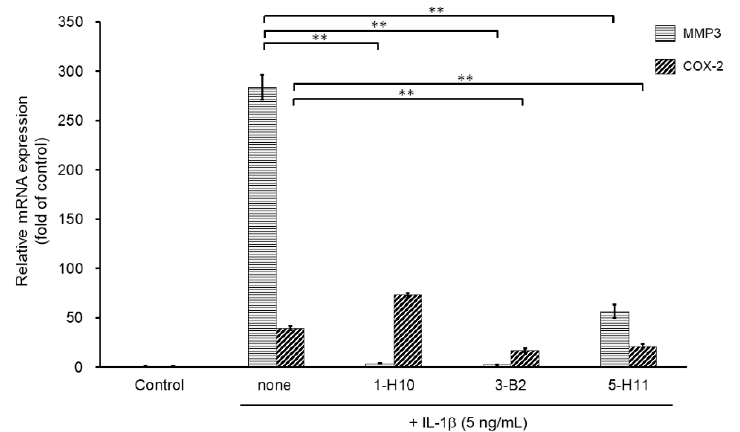
Figure 4. Inhibitory effects of candidate compounds on IL-1 β -induced MMP3 and COX-2 mRNA expression. Cells were treated with each compounds (10 µ g/mL) for 24 h, followed by the stimulation with IL-1 β (5 ng/mL) for 6 h. Levels of MMP3 and COX-2 mRNAs levels were calculated relative to their mRNA levels in uninduced control cells. Values represent mean ± SE ( n = 6 per group). ** p < 0.01.